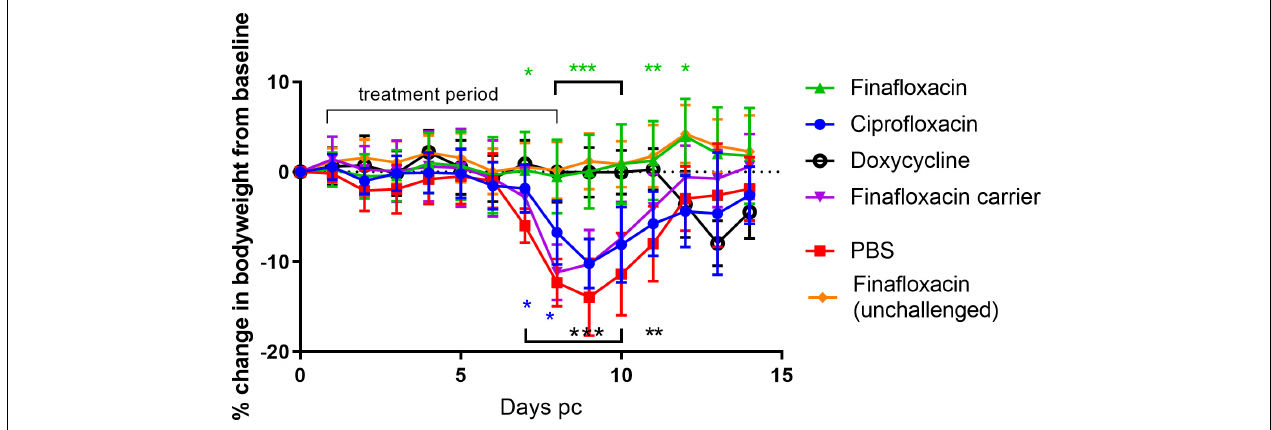
FIGURE 1 | Bodyweight loss in mice infected with C. burnetii and treated with antibiotics. At 24 h post-challenge mice were treated with finafloxacin (30 mg/kg once a day orally), ciprofloxacin (22 mg/kg every 12 h via intraperitoneal injection) or doxycycline (105 mg/kg once daily orally) for 7 days. Control animals received PBS or the carrier orally. One group of mice received finafloxacin only (not challenged). Mean and standard errors are shown. Statistical difference from PBS treated controls, * p < 0.05, ** p < 0.01*** p < 0.001, color denotes group.